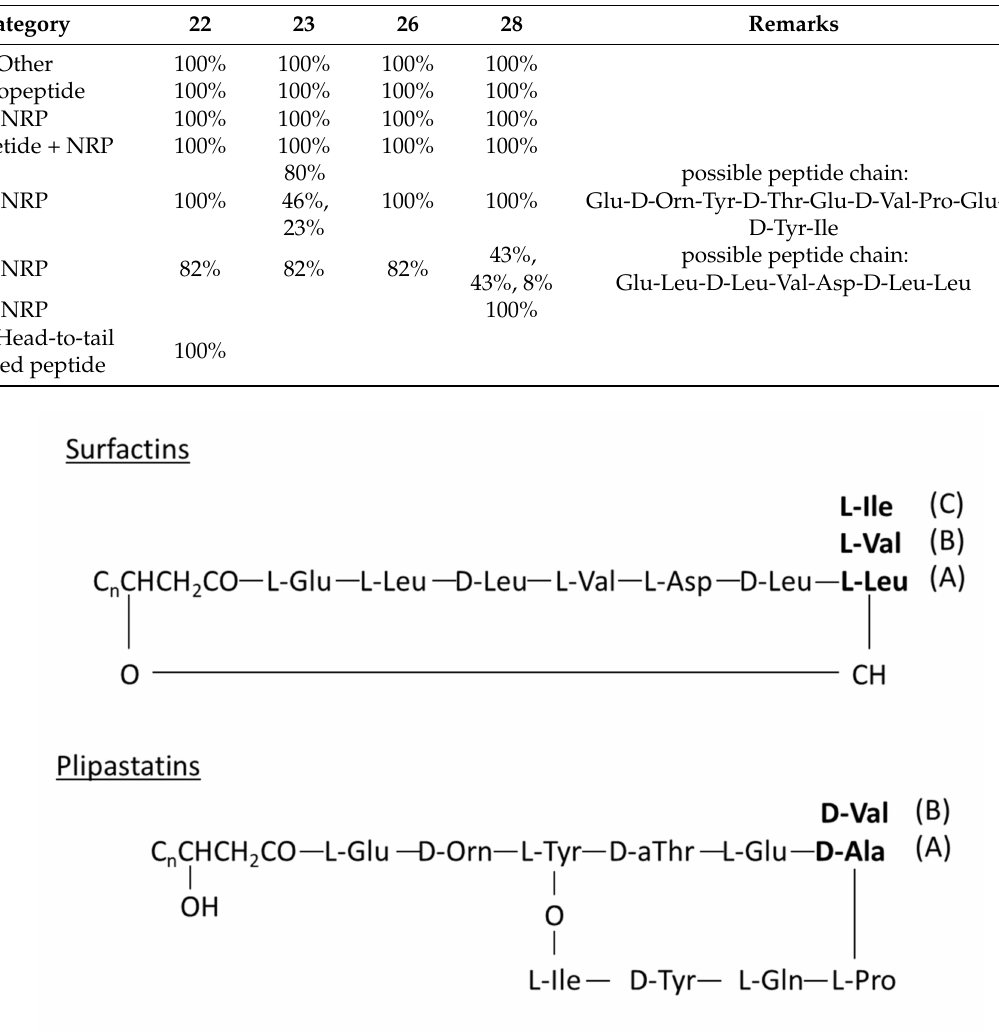
Figure 7. Primary structures of surfactins and plipastatins [11,32]. The letters in brackets correspond to the different possible amino acids in position